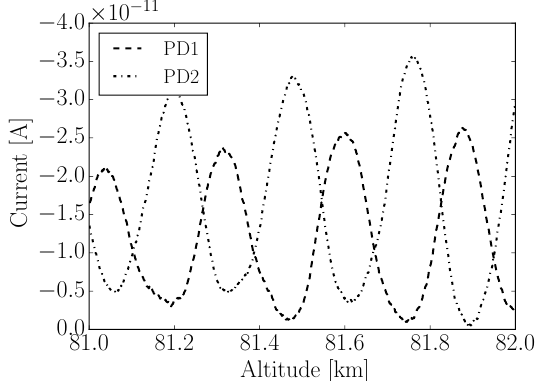
Figure 7. Smoothed PD currents (dashed: PD 1; dashed-dotted: PD 2) as a function of altitude.